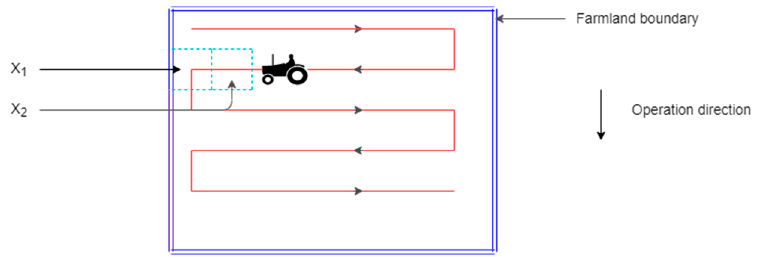
Figure 4. Schematic diagram of parallel work path generation. X 1 is the front grid that reminds you where to turn; X 2 is an empty position in the front grid.